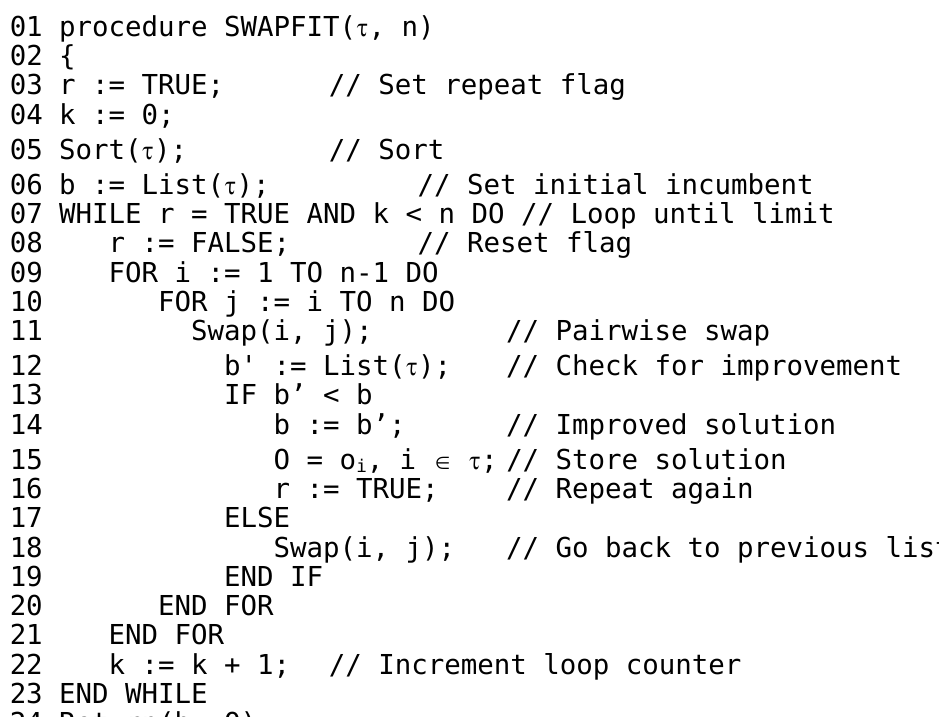
Figure 7. SWAPFIT algorithm, in